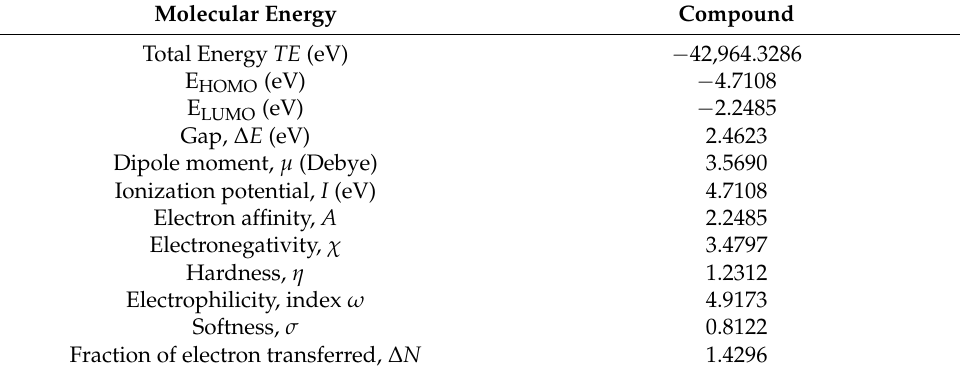
Table 2. Calculated